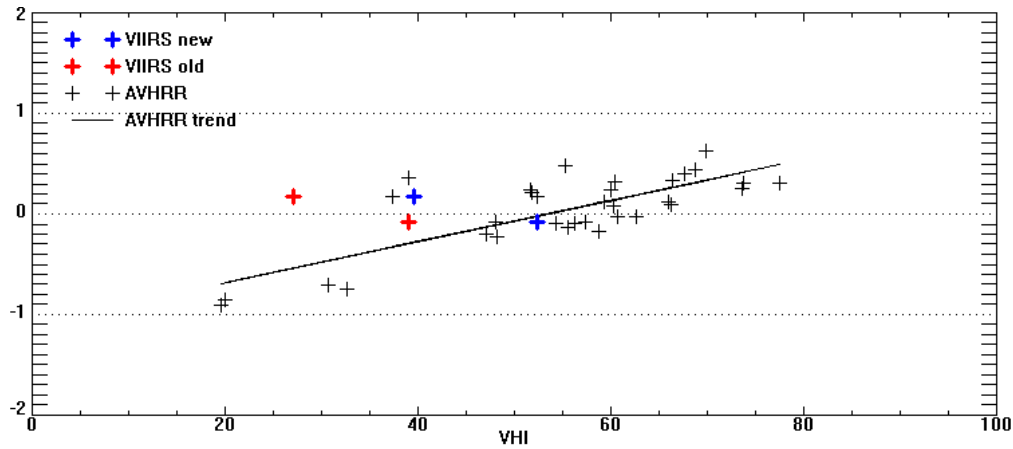
Figure 6. Scatter plots and regression of hard wheat dY versus weekly Vegetation Health Index (VHI) during crop’s critical period in Australia.